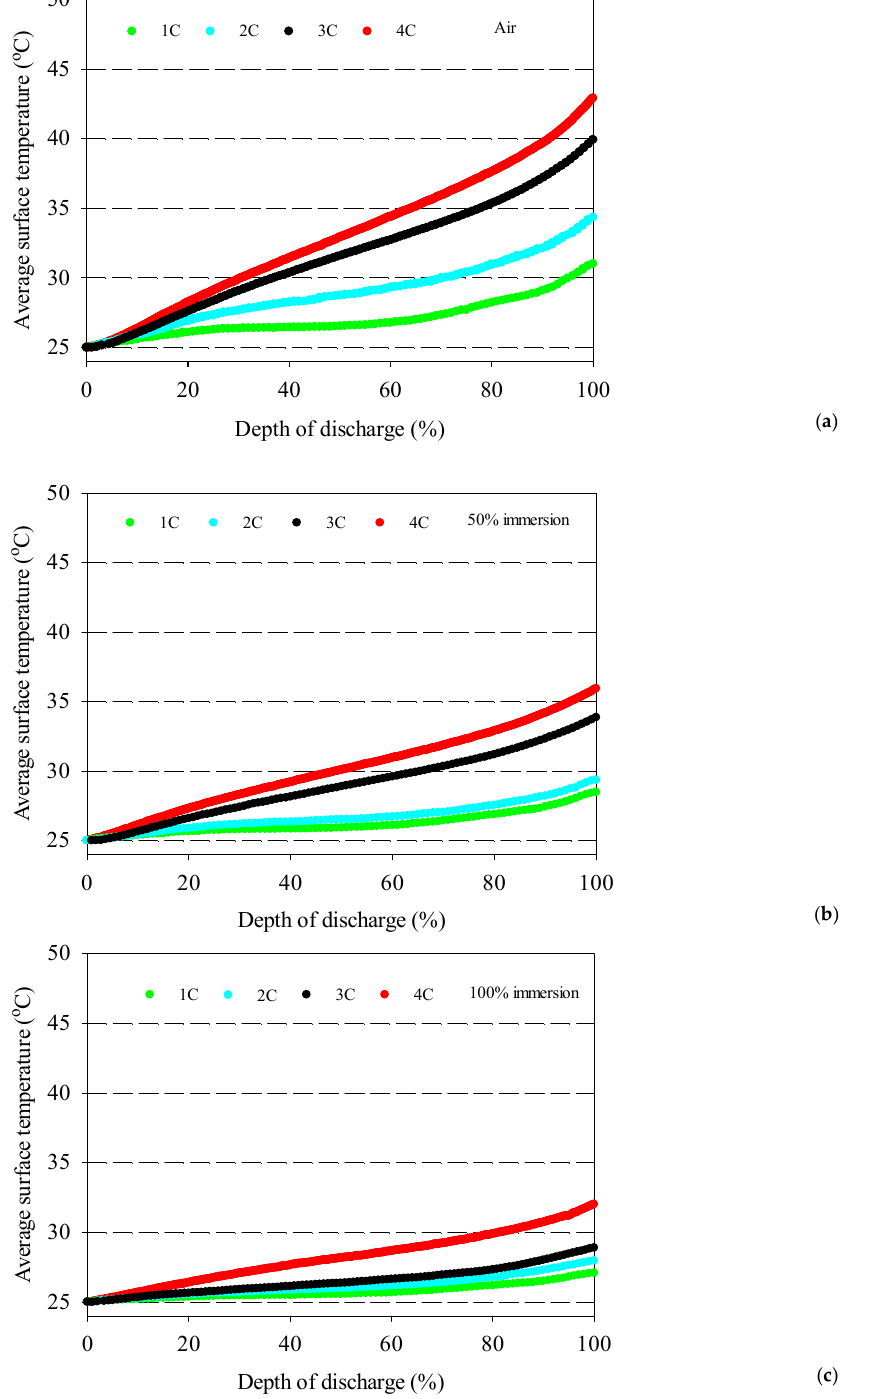
Figure 6. The effect of discharge rate on average battery surface temperature for ( a ) air, ( b ) 50% immersion, ( c ) 100% immersion (T inlet = 25 °C).